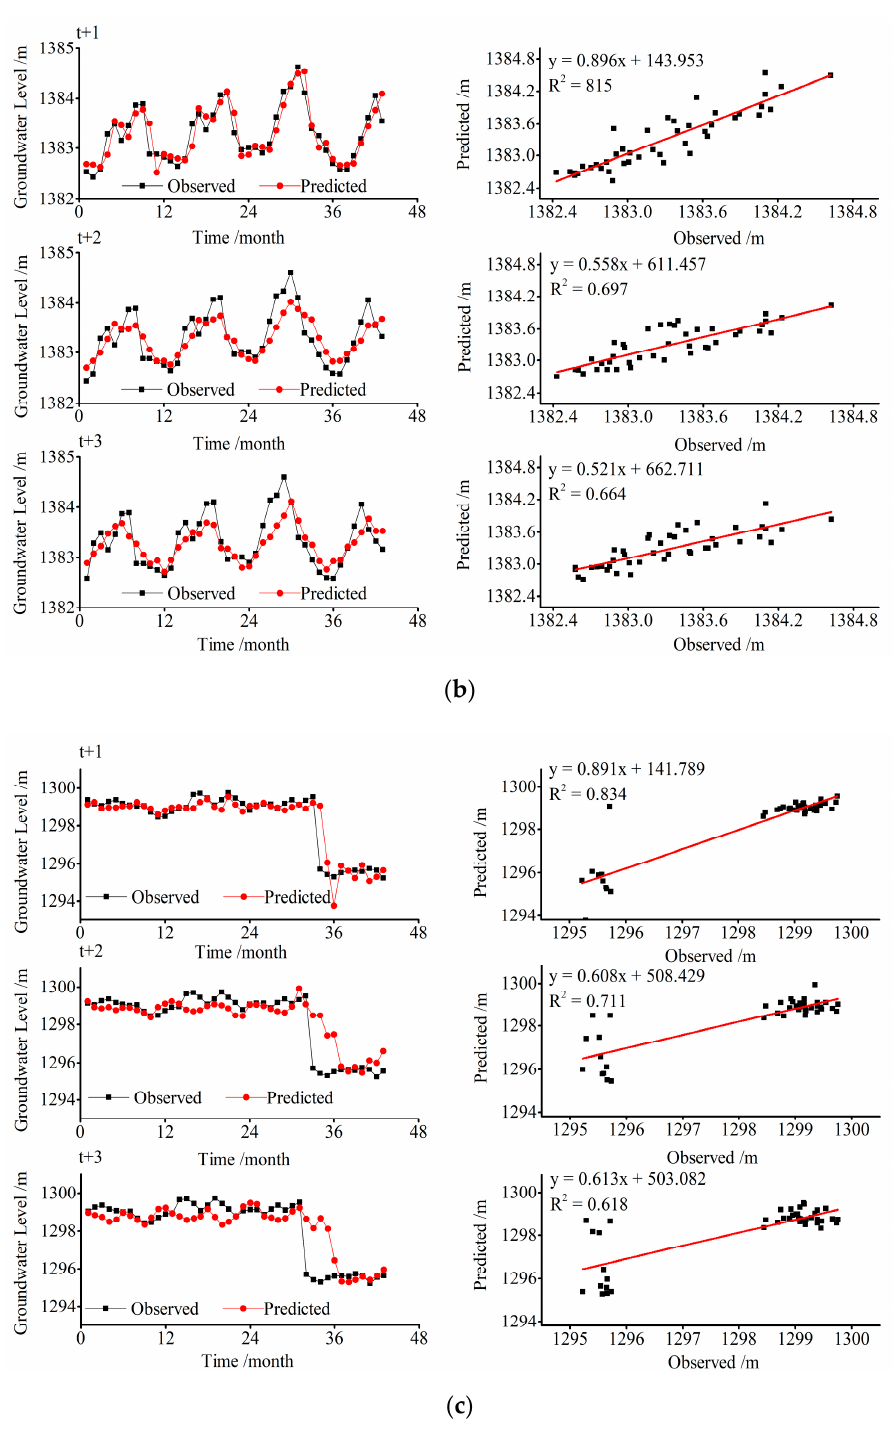
Figure 7. Observed groundwater level and forecasted by ELM model for 1, 2 and 3-months ahead during the testing period at Well I ( a ), Well II ( b ) and Well III ( c ).